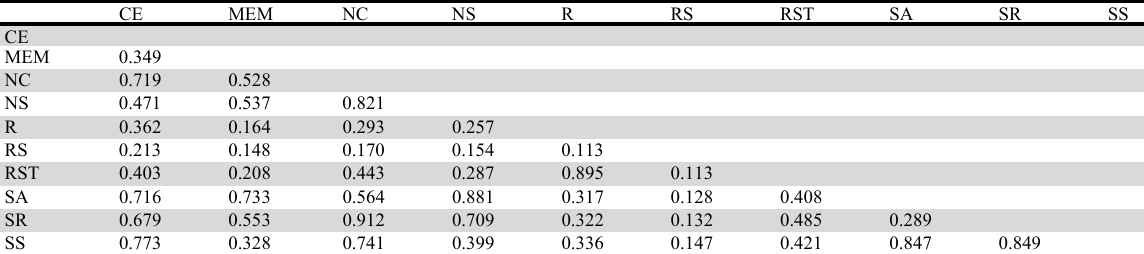
Discriminant validity: Heterotrait–monotrait ratio